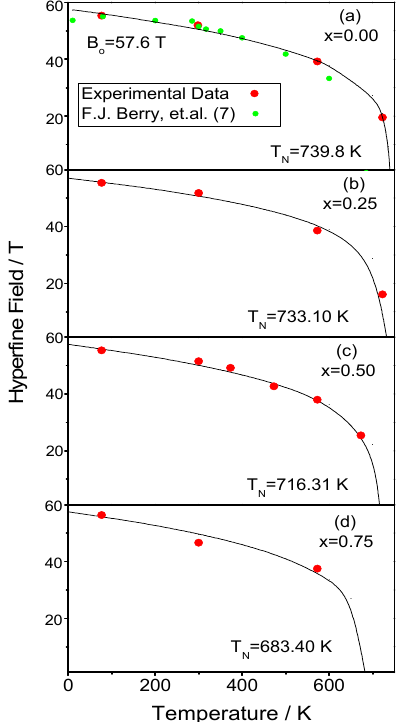
Figure 5. Dependence of the magnetic hyperfine field with the temperature for: ( a ) x = 0.00; ( b ) x = 0.25; ( c ) x = 0.50; and ( d ) x = 0.75.